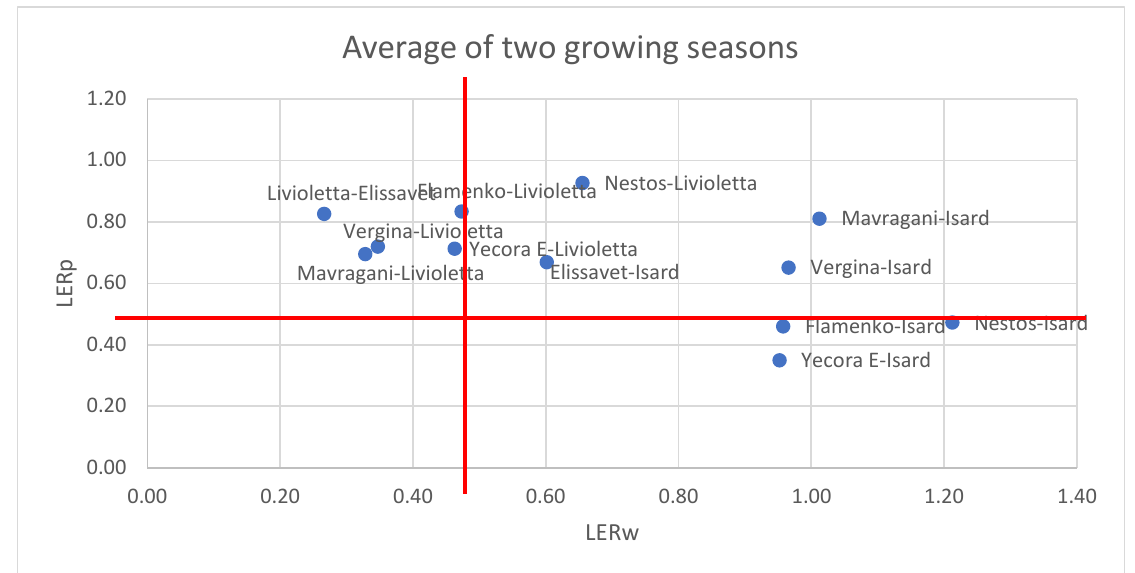
Figure 3. Graphical representation of the interaction between the two species based on the average partial LER values of pea (LERp) and wheat (LERw) of the intercropping systems under evaluation for two growing seasons.